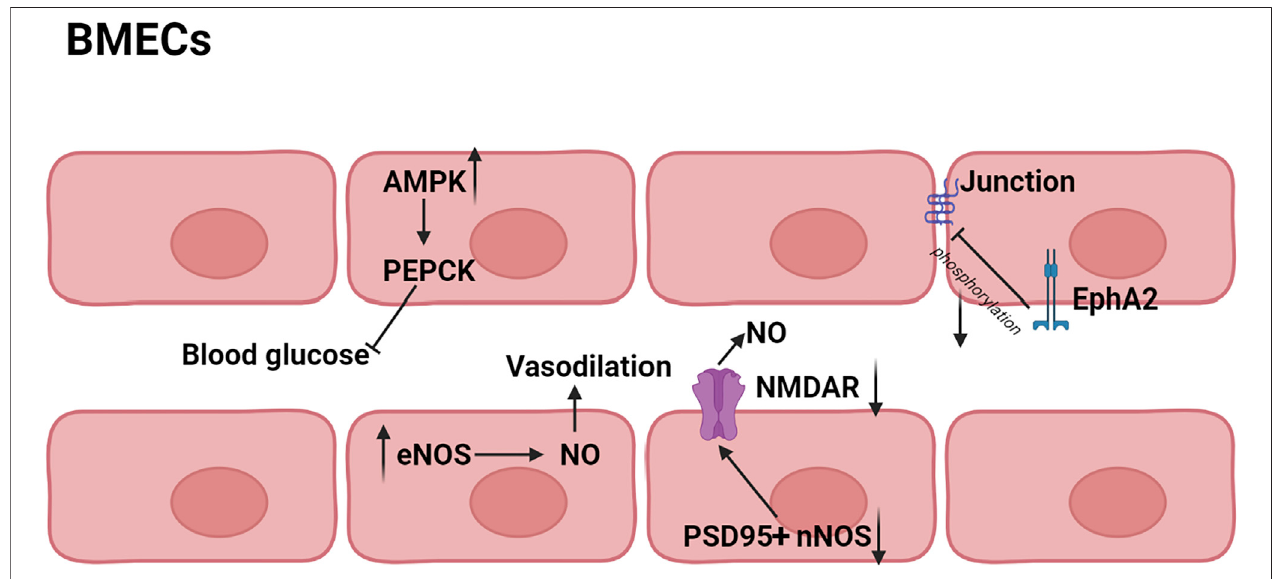
FIGURE 7 | Mechanisms involved in the protection of BMECs by